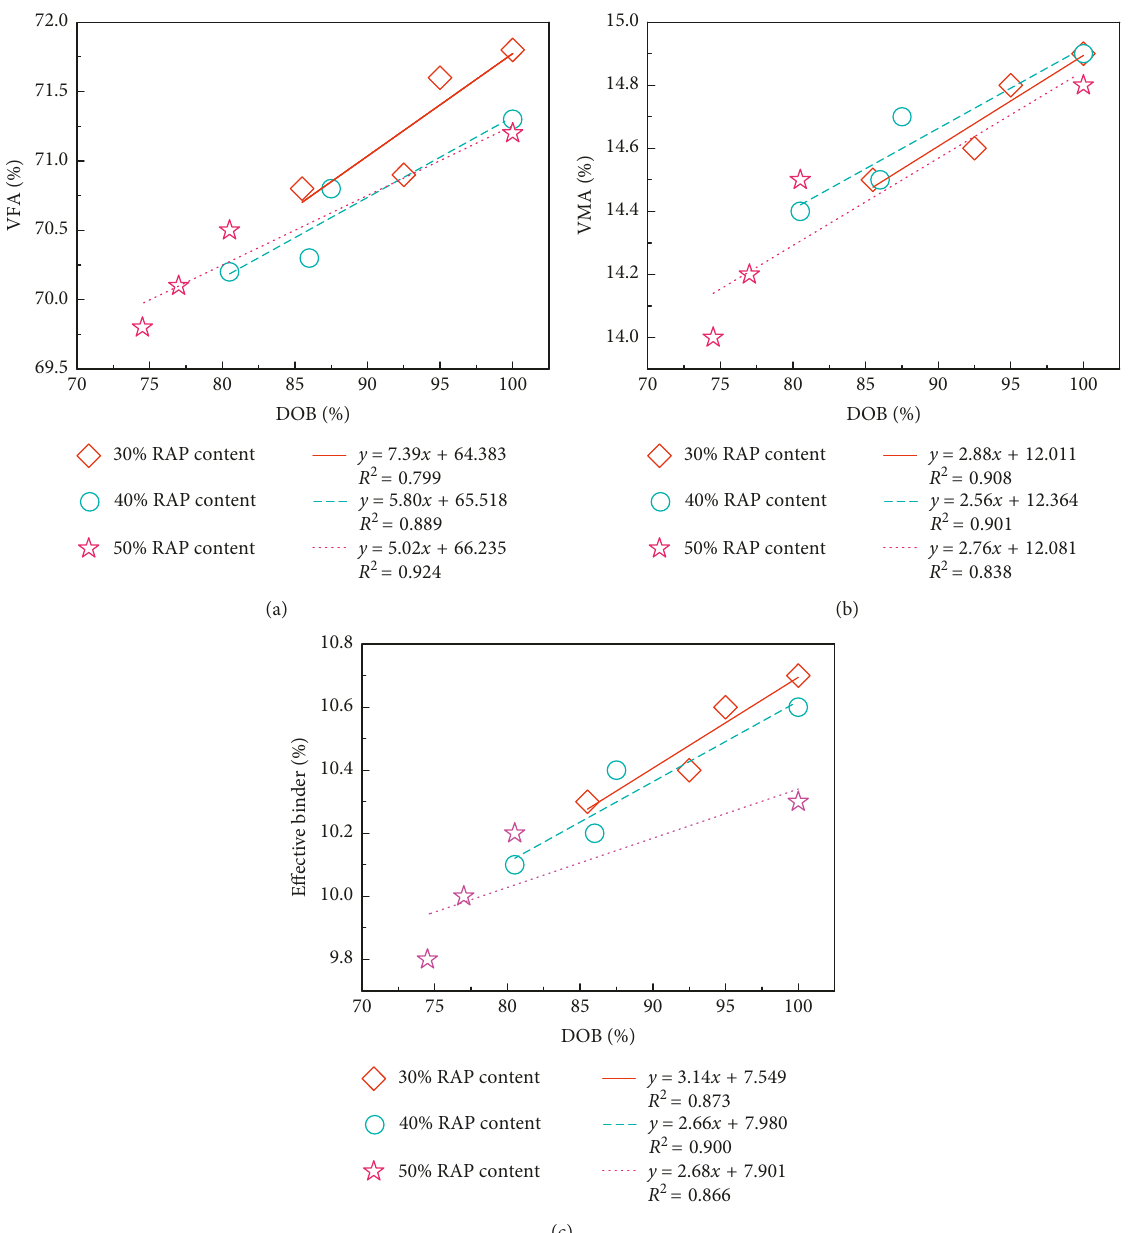
Figure 4: The relationship between VMA, VFA, and effective binder volume and DOB. Table 15: Results of ANOVA with dual-factor repeated test ( α